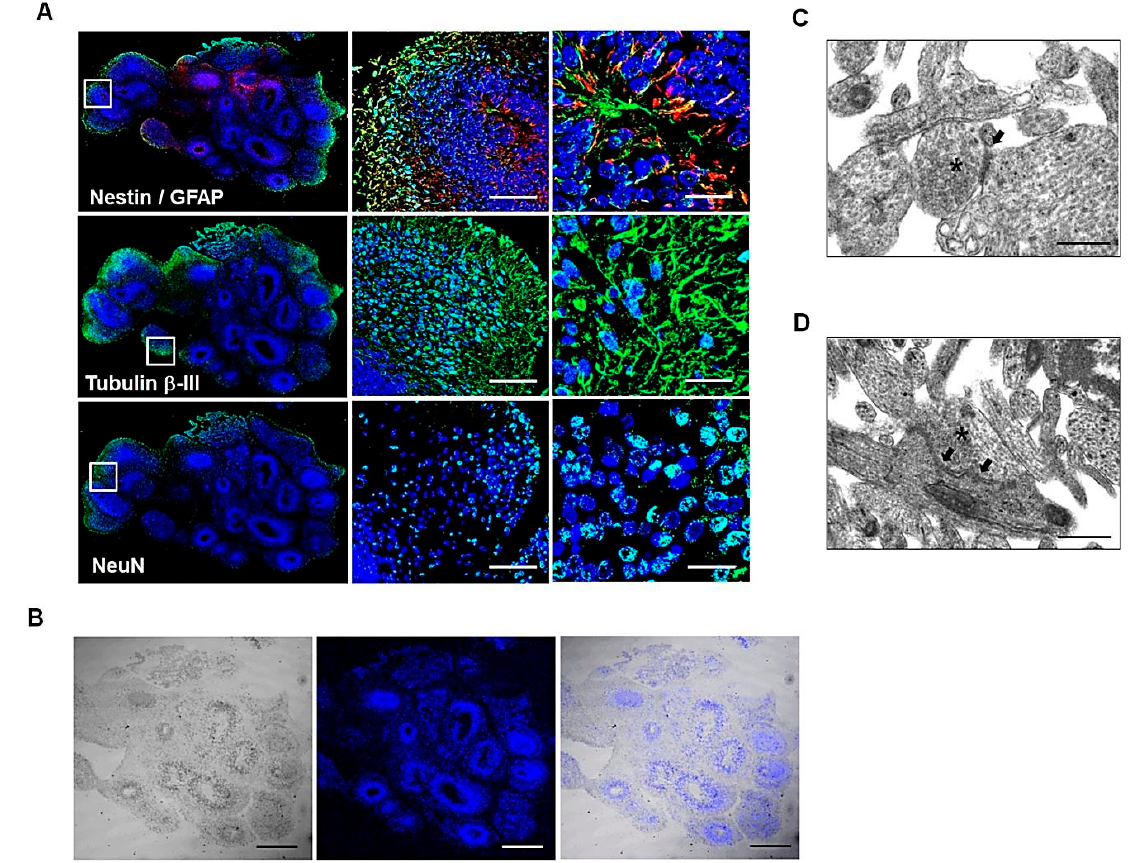
Figure 1. Characterization of hBOs in culture. ( A ) Confocal microscopy images of hBOs stained with antibodies against Nestin, GFAP, Tubulin β -III, and NeuN at day 60 in differentiation medium. Scale bars: 50 μ m or 20 μ m. ( B ) Confocal fluorescent image overlaid on the DIC image of hBO. Scale bar: 500 μ m. ( C , D ) TEM images of cortical organoids showing synaptic clefts (head arrows) and synaptic vesicles (asterisks). Scale bar: 500 nm. All images are representative of two or three independent experiments.